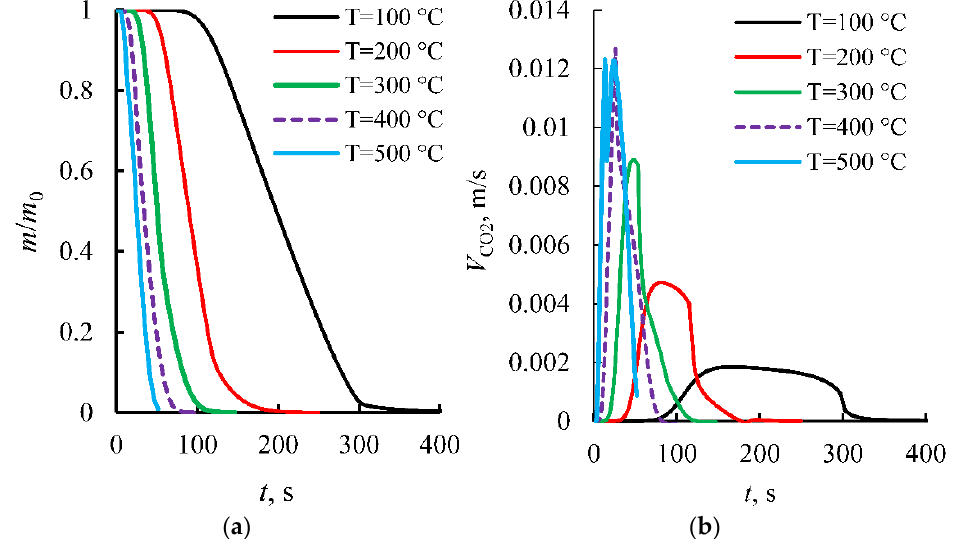
Figure 18. ( a ) Dissociation of a CO 2 hydrate tablet with varying ambient temperature T ( m 0 is the initial mass of gas hydrate, the tablet diameter is 20 mm, and the tablet height is 5–6 mm). ( b ) Carbon dioxide release rate during the dissociation with varying tablet porosity P and ambient gas temperature T .